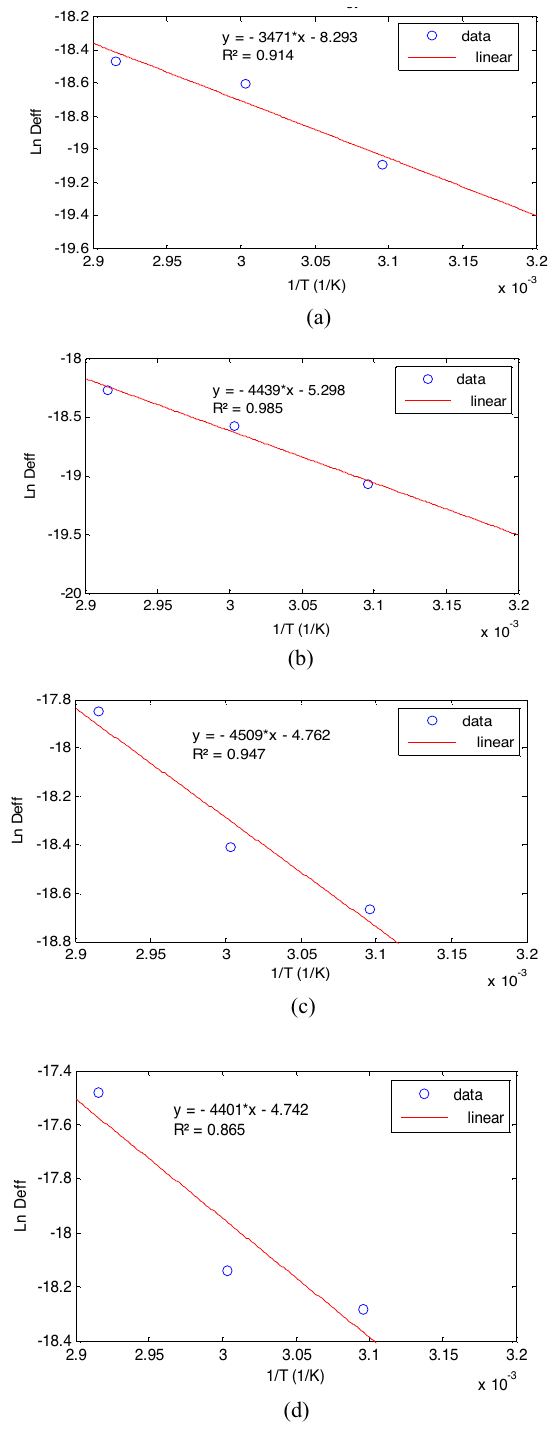
Figure 4. Estimation of the activation energy of ( a ) unblanched, ( b ) 10 min blanched, ( c ) 5 min blanched and ( d ) 3 min